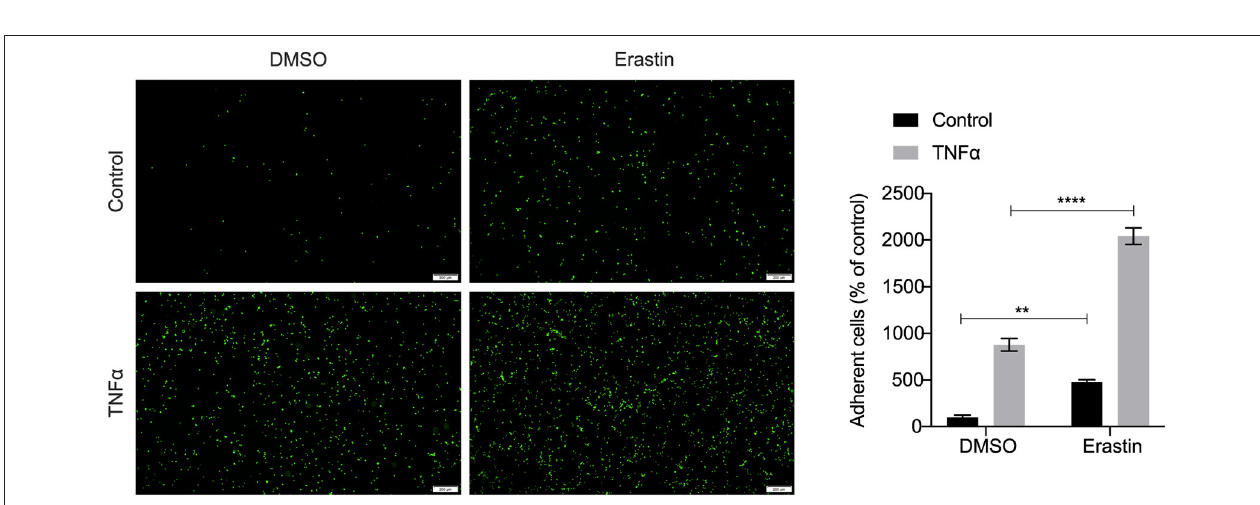
FIGURE 9 | Representative pictures of the adhesion of fluorescently labeled THP-1 cells on HASMC monolayers. HASMCs were treated with DMSO (as control) or erastin (2 µ M) for 24h, then stimulated with or without TNF α (10ng/ml) for 6h and THP-1 cells, labeled with a fluorescent dye Calcein AM (5 µ M), were added to HASMCs. After adhering, THP-1 cells bound to HASMCs were photographed by fluorescent microscopy and counted using Image J software. (The error bars represent standard error of mean from five images per well. ** p < 0.01, **** p < 0.0001, compared between the groups by t